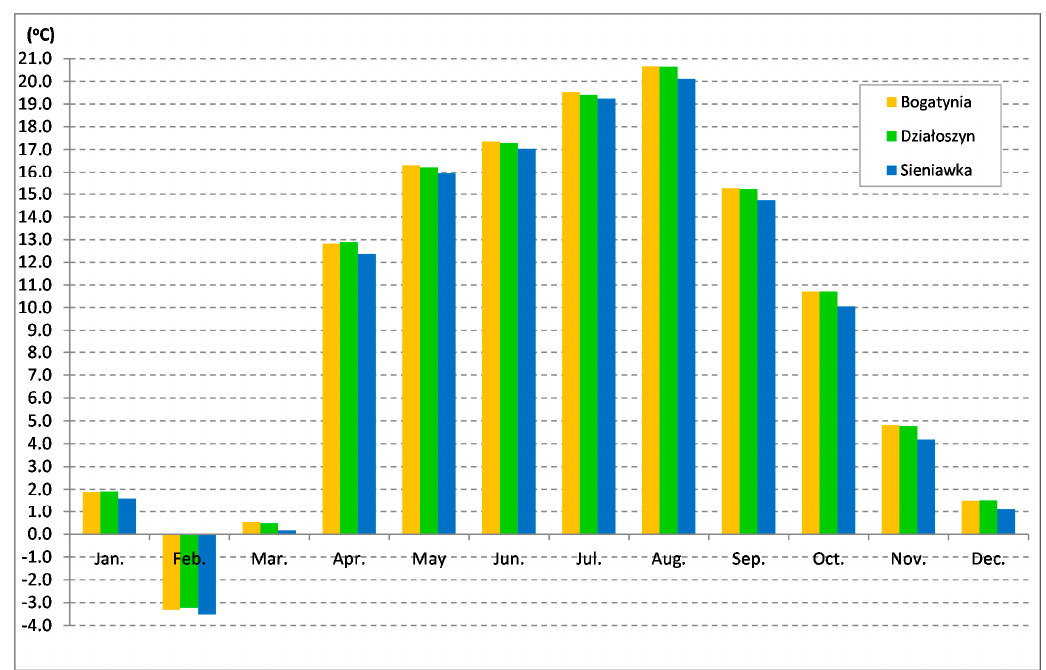
Figure 12. The course of the monthly mean air temperature determined by the WRF/CALMET model in selected towns in 2018 (source: own study).